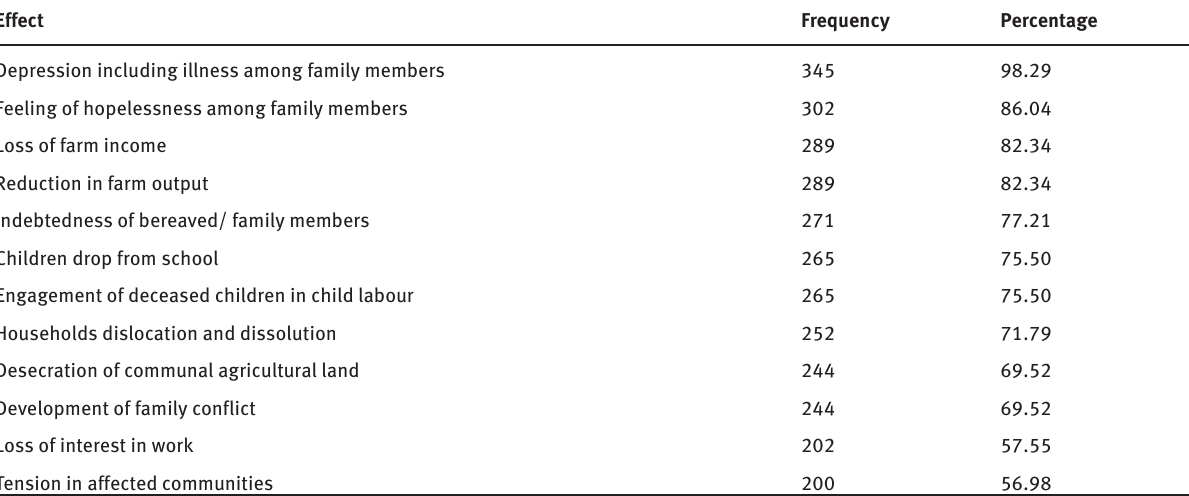
Table 6: Perceived effects of suicide on agriculture and rural communities